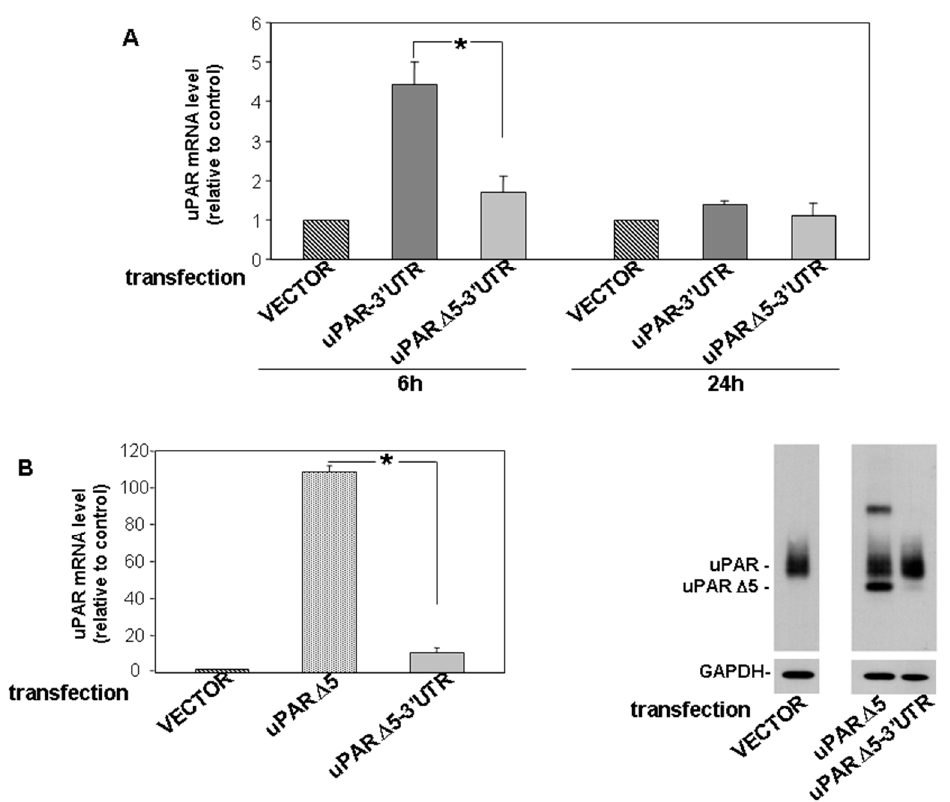
Figure 3. The 3 ′ UTR confers instability to the uPAR Δ 5 transcript. ( A ) KG1 cells were transiently transfected with the cDNA of uPAR-3 ′ UTR or uPAR Δ 5-3 ′ UTR, or with the empty vector as a control; cells were harvested 6 h and 24 h after transfection. uPAR transcript levels, analysed by qRT-PCR and normalized to the GAPDH mRNA, are expressed as fold change of endogenous uPAR expressed by KG1 cells transfected with the empty vector. The relative level of expression was calculated with the formula 2 −ΔΔ CT . Values are the mean ± SEM of three experiments performed in triplicate; * p < 0.05 as determined by the Student’s t test. ( B ) KG1 cells were transiently transfected with the cDNA of uPAR Δ 5 carrying (uPAR Δ 5-3 ′ UTR) or not (uPAR Δ 5) the 3 ′ UTR, or with the empty vector, as a control; cells were harvested 6 h after transfection. uPAR transcript levels, analysed by qRT-PCR and normalized to the GAPDH mRNA, are calculated with the formula 2 −ΔΔ CT relative to the endogenous uPAR expressed by KG1 cells transfected with the empty vector. Values are the mean ± SEM of three experiments performed in triplicate; * p < 0.05 as determined by the Student’s t -test (left panel). Part of KG1 transfected cells were lysed in 1% TRITON X-100 and 10 μ g of cell lysates were analysed by Western blot with an anti-uPAR specific antibody; the filter was then rep- robed with a rabbit anti-GAPDH antibody as a loading control (right panel). Original Western Blot can be found at supplementary materials.